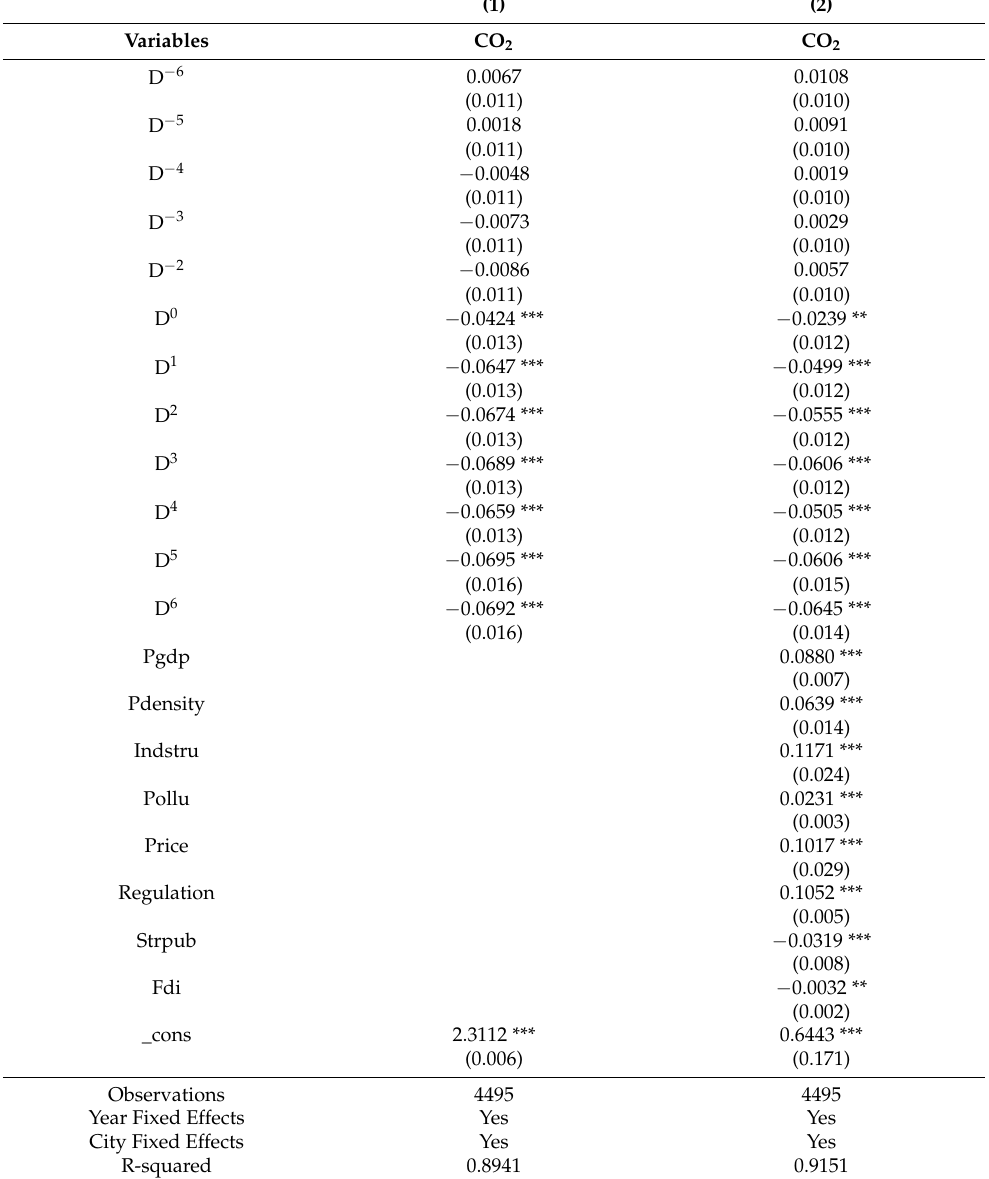
Table 13. Parallel Trend Test: carbon